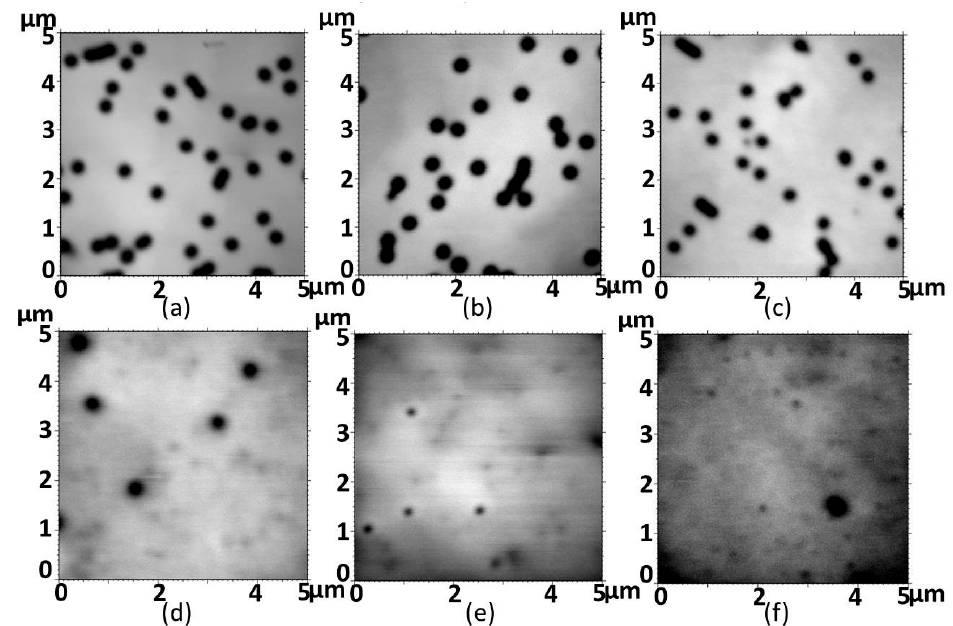
Figure 2. Cathodoluminescence (CL) monochromatic images of LED surfaces. Large V-pit samples with ( a ) 2- µ m-thick, ( b ) 4- µ m-thick, and ( c ) 6- µ m-thick n-type GaN layers, respectively. Small V-pits samples with ( d ) 2- µ m-thick, ( e ) 4- µ m-thick, and ( f ) 6- µ m-thick n-type GaN layers, respectively.